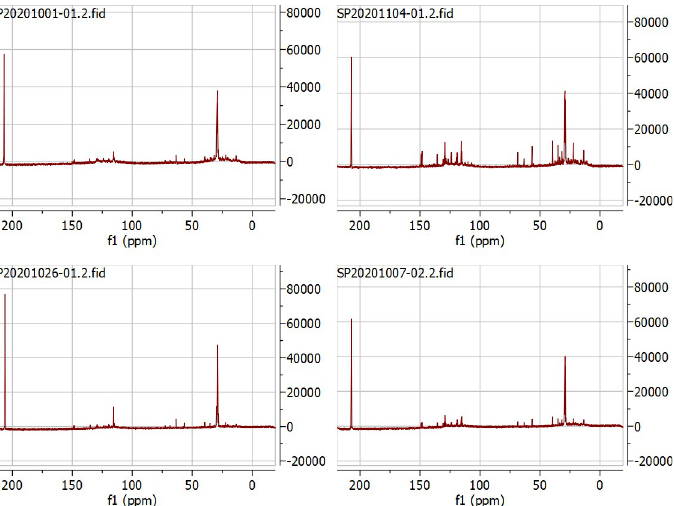
Fig 5. 13 C NMR spectra of the organic oils obtained in different temperature (a) 450˚C, (b) 500˚C, (c) 550˚C and (d) 600˚C.